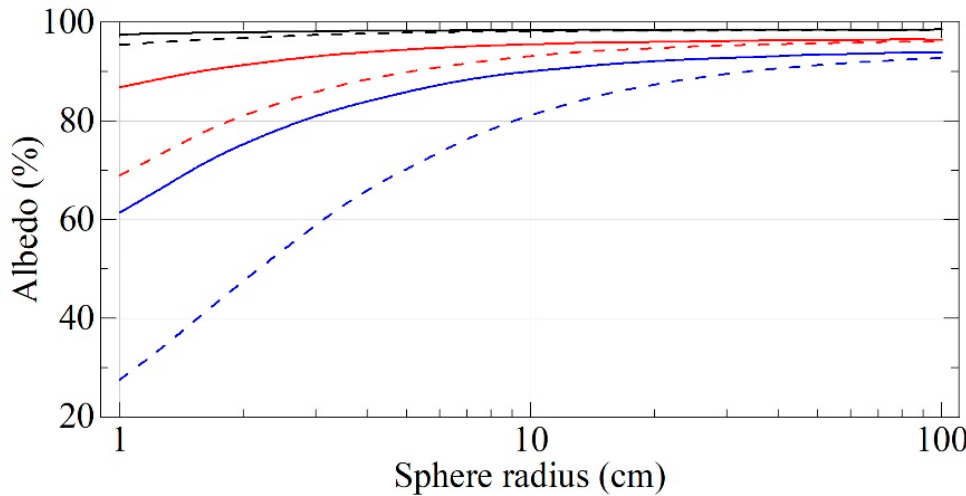
Figure 12. Neutron albedo for the velocities of 50 m/s (black lines), 100 m/s (red lines), and 150 m/s (blue lines) for F-DNDs (dashed lines) and DF-DNDs (solid lines) versus the cavity radius. The incident neutrons are isotropic, the powder thickness is infinite, and densities of F-DNDs and DF-DNDs are equal to 0.19 and 0.56 g/cm 3 , respectively.